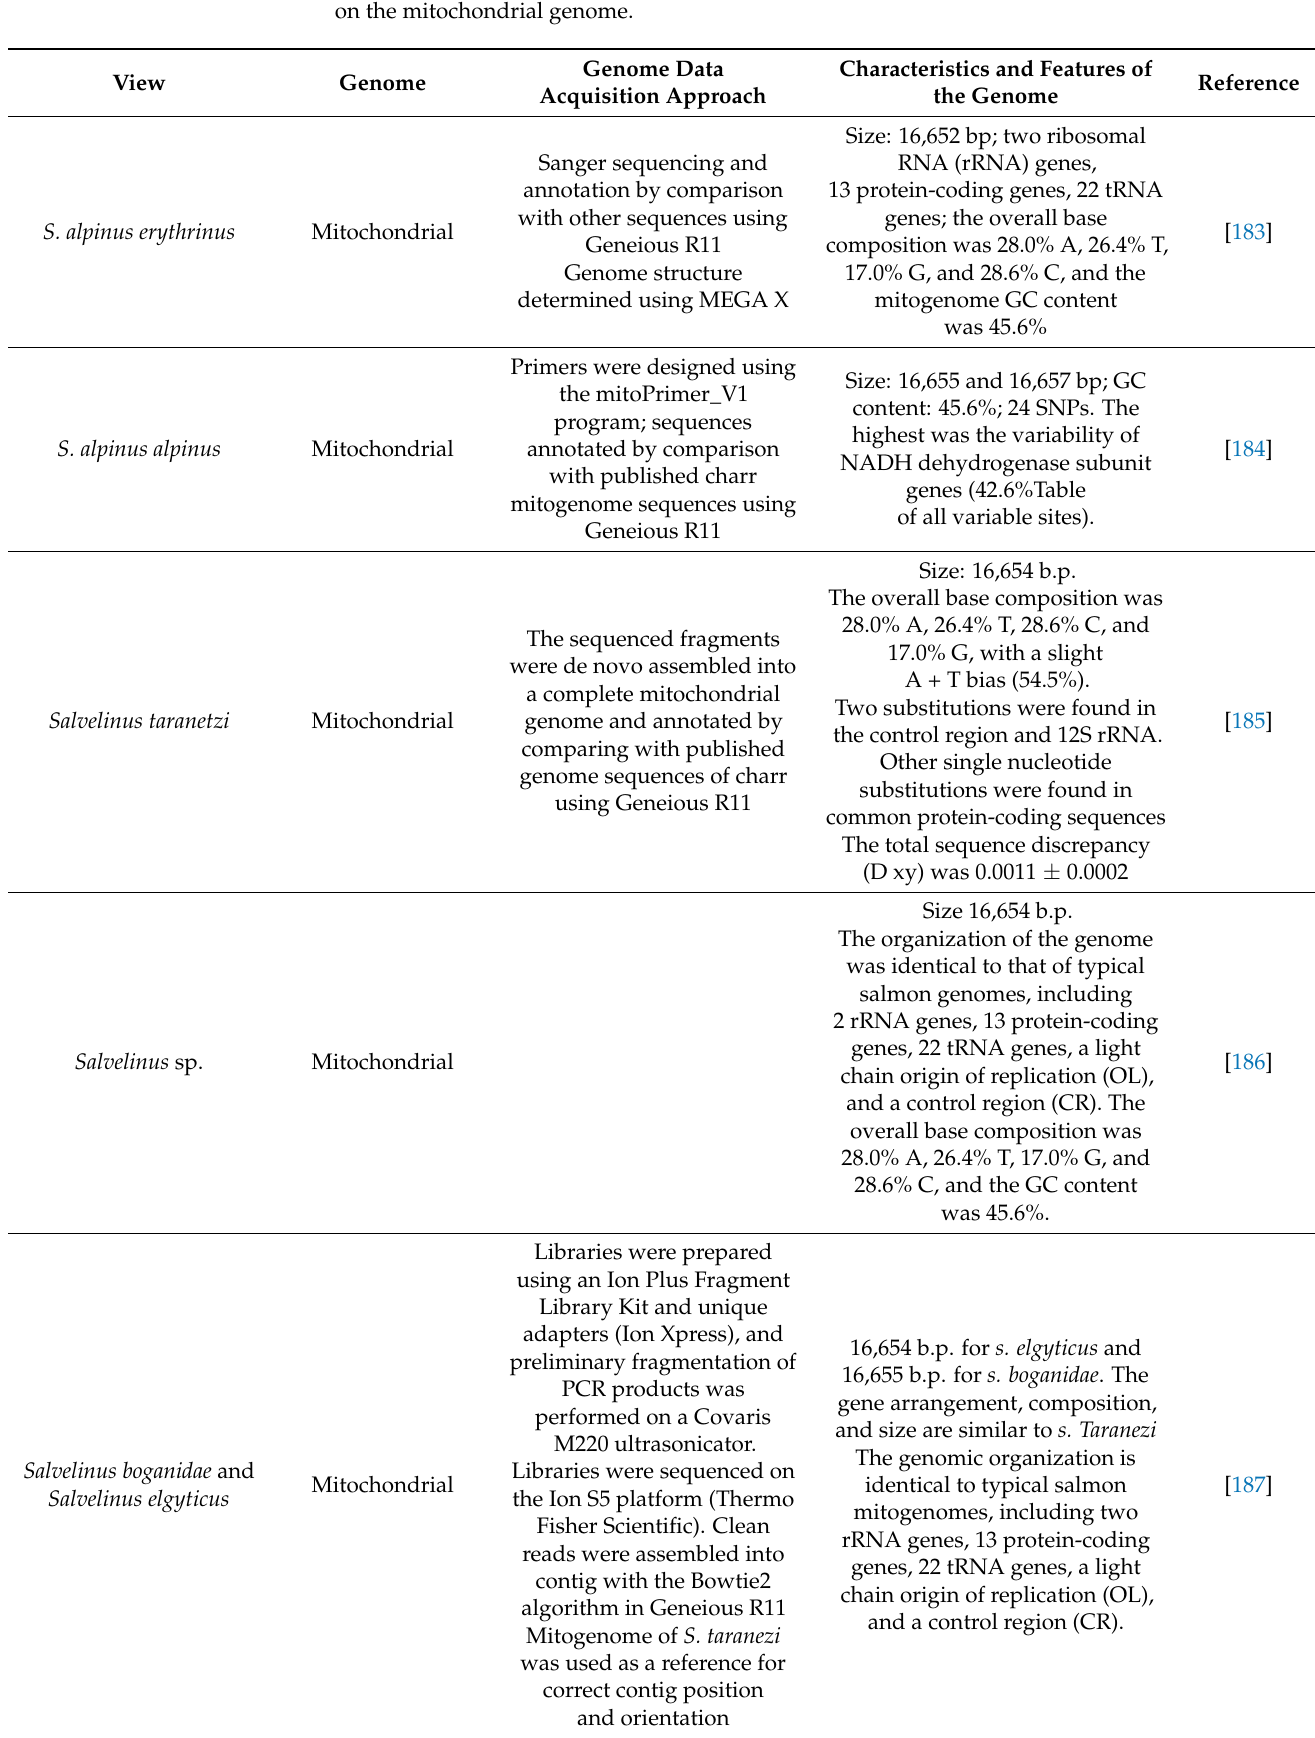
Table 1. Data on salmon genomes ever obtained. As we can assess, the great majority of studies focus on the mitochondrial